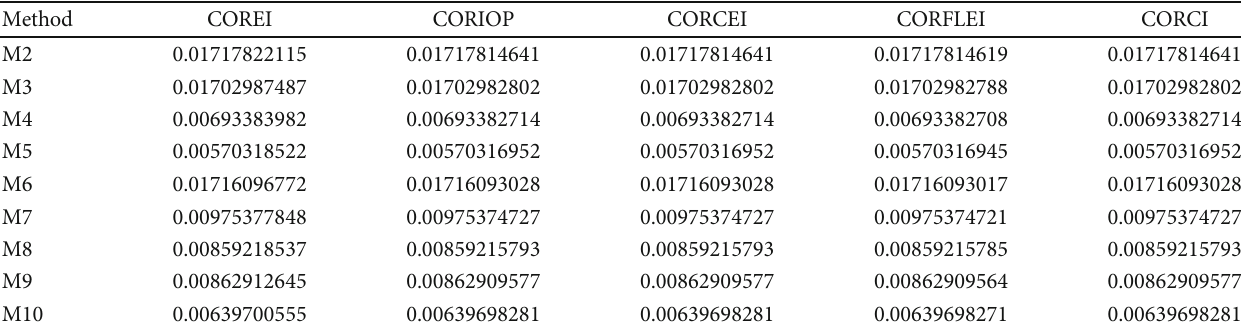
Table 36: Values of corrected e ffi ciency indices for the methods in the fi rst category to solve Test Problem 1, and n = 500 .